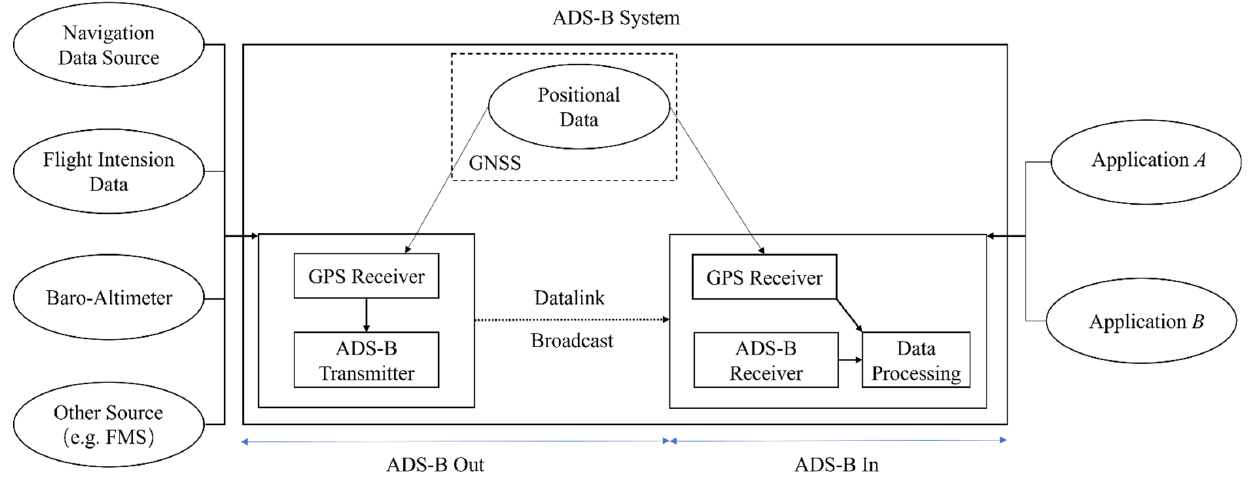
Figure 1. Introduction to ADS ‐ B system.